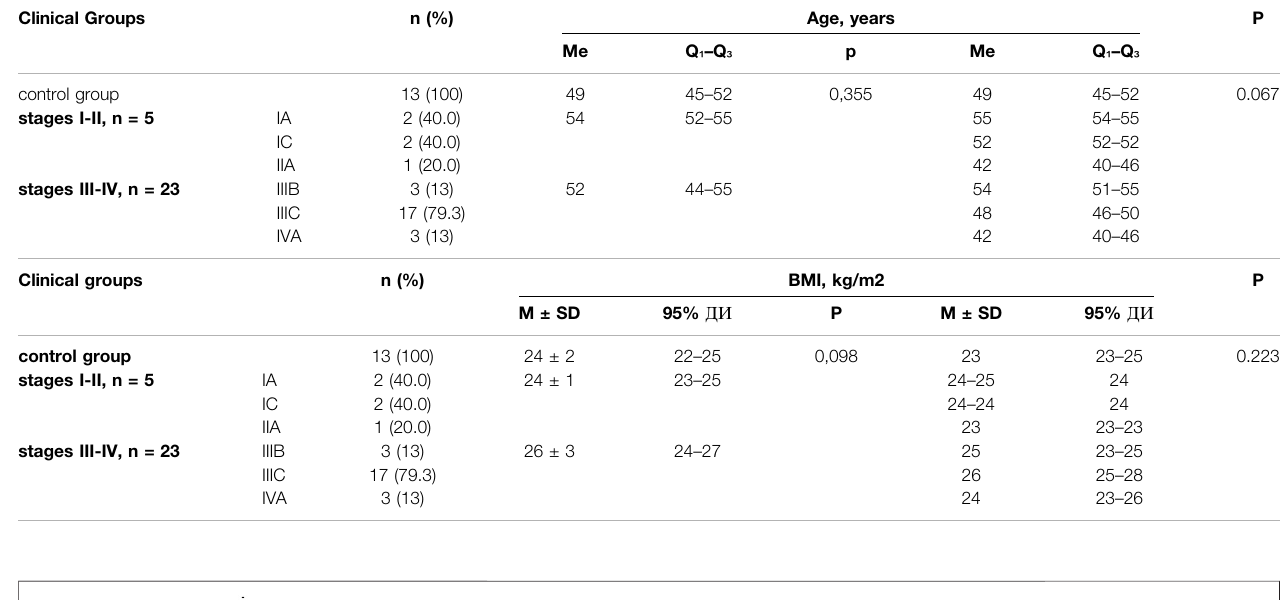
TABLE 1 | Clinical data of patients of the study cohort and control group. Clinical Groups